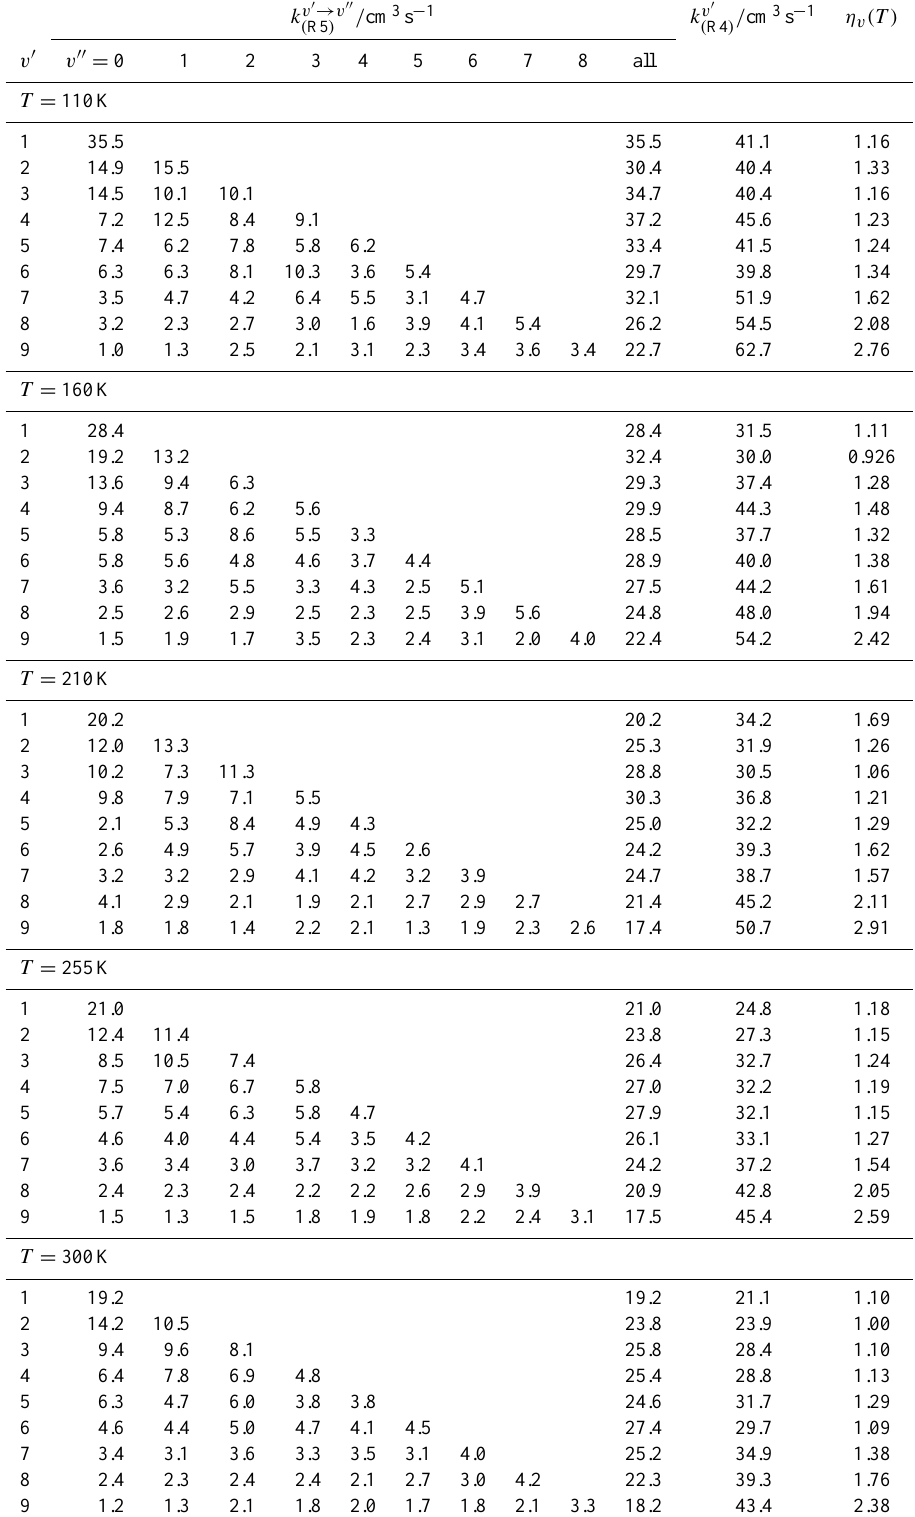
Table 1. State-to-state, state-to-all, and state-specific rate constants (multiplied by 10 12 ) for the O + OH (v)